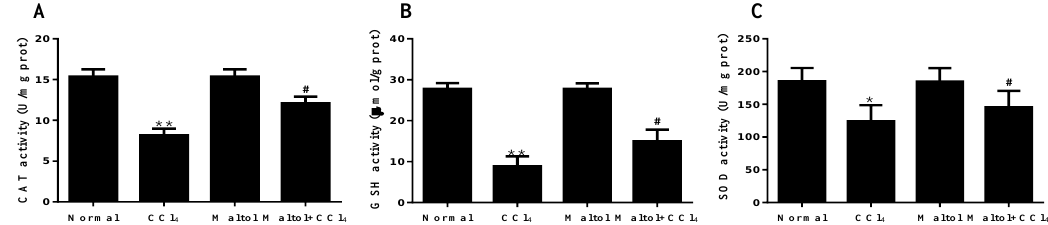
Figure 4. Pretreatment with maltol protected against CCl 4 -induced liver injury: Effects of maltol on the hepatic of catalase (CAT) ( A ), glutathione (GSH) ( B ), superoxide dismutase (SOD) ( C ) in CCl 4 -induced mice; values are expressed as the mean ± S.D., n = 8. * p < 0.05, ** p < 0.01 vs. normal group; # p < 0.05 vs. CCl 4 group.